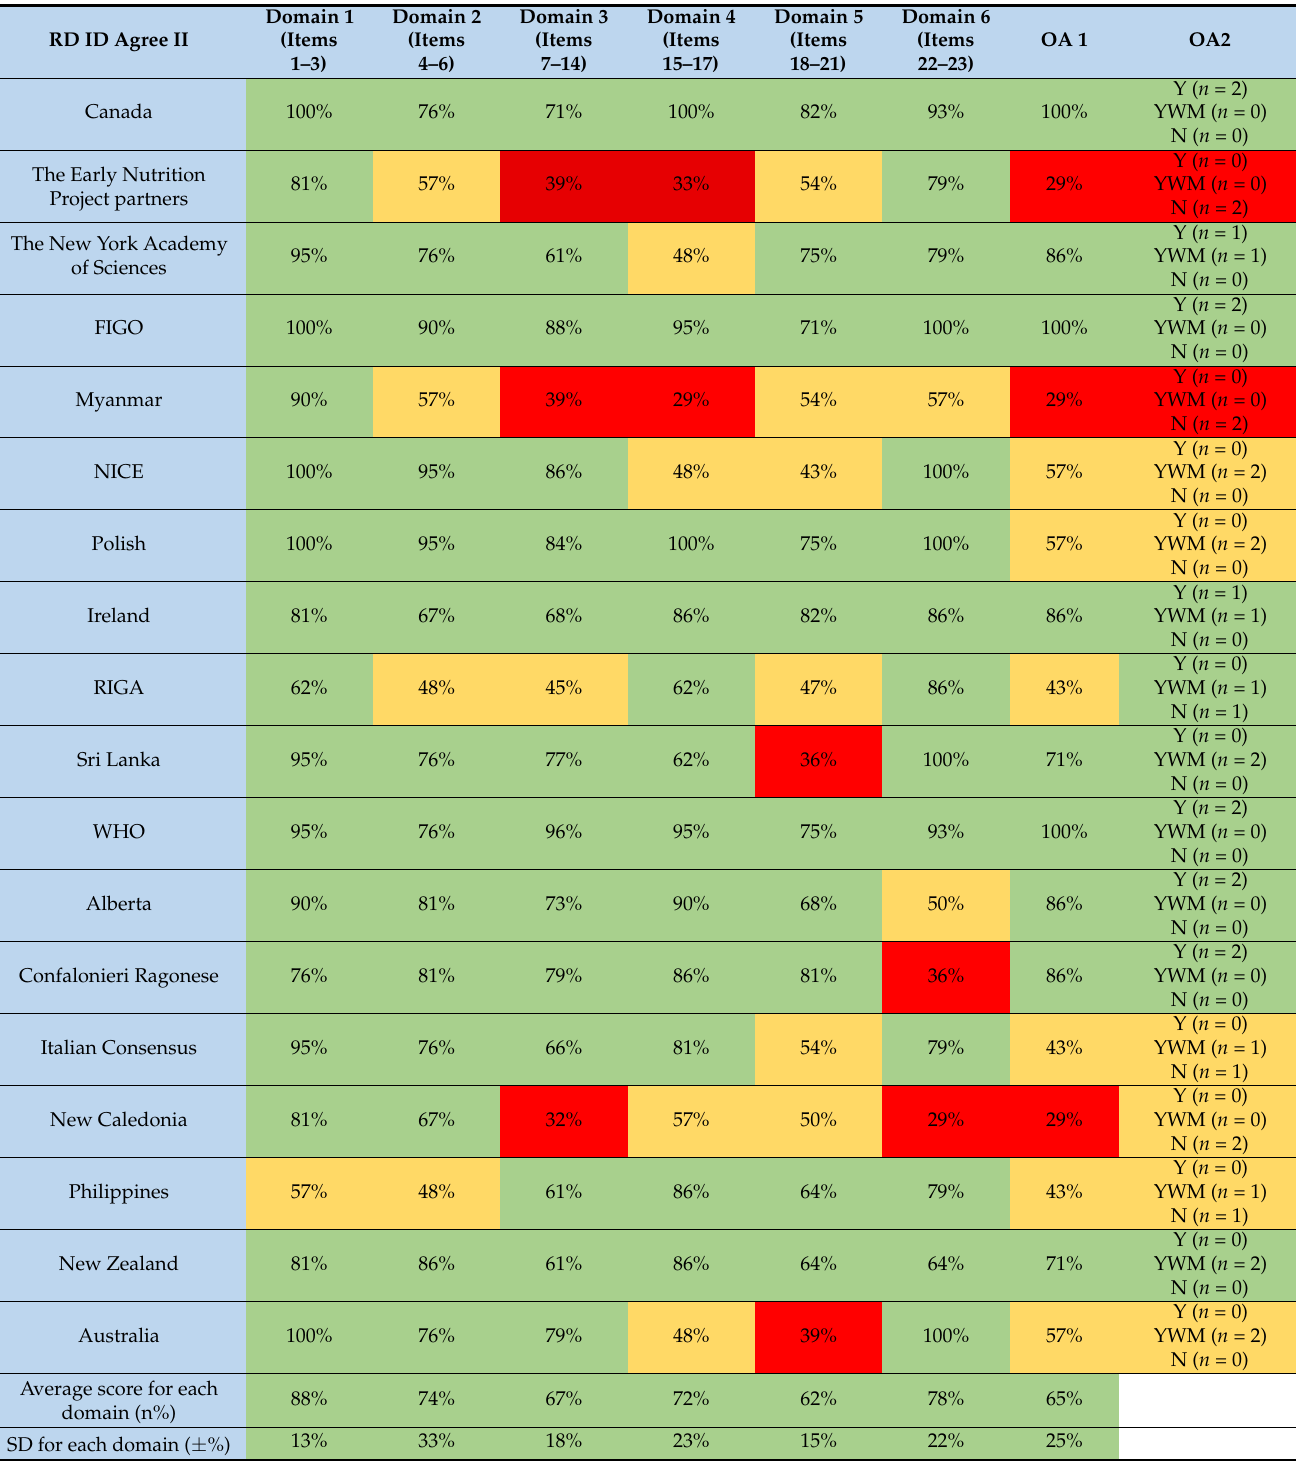
Green color: recommended; yellow color: revised recommended; red color: not